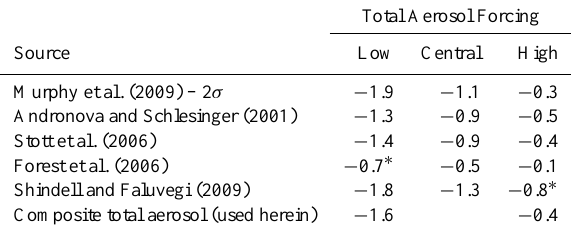
Table 2. Total aerosol forcing ranges (see text) estimated from sev- eral studies. Except where noted, ranges represent a 5–95%